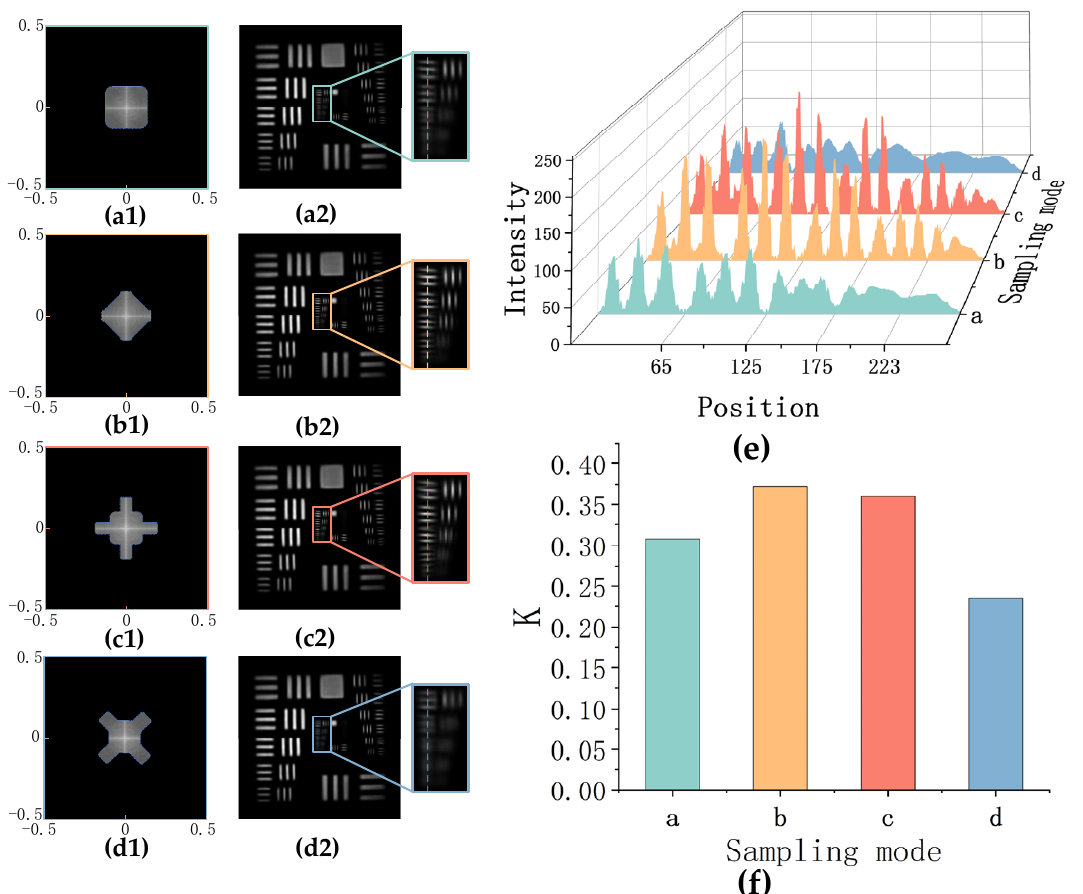
Figure 7. Experimental sampling mode, imaging results and analysis. ( a1 – d1 ) Four different experimental sampling areas. The overlap of adjacent apertures is 70% in both the horizontal and vertical directions. ( a2 – d2 ) Imaging results and enlarged images corresponding to four different sampling modes. ( e ) The pixel intensity distribution map of the horizontal stripes at group number 2 intercepted at the drawn line. ( f ) The structural similarity values K corresponding to different reconstructed images.